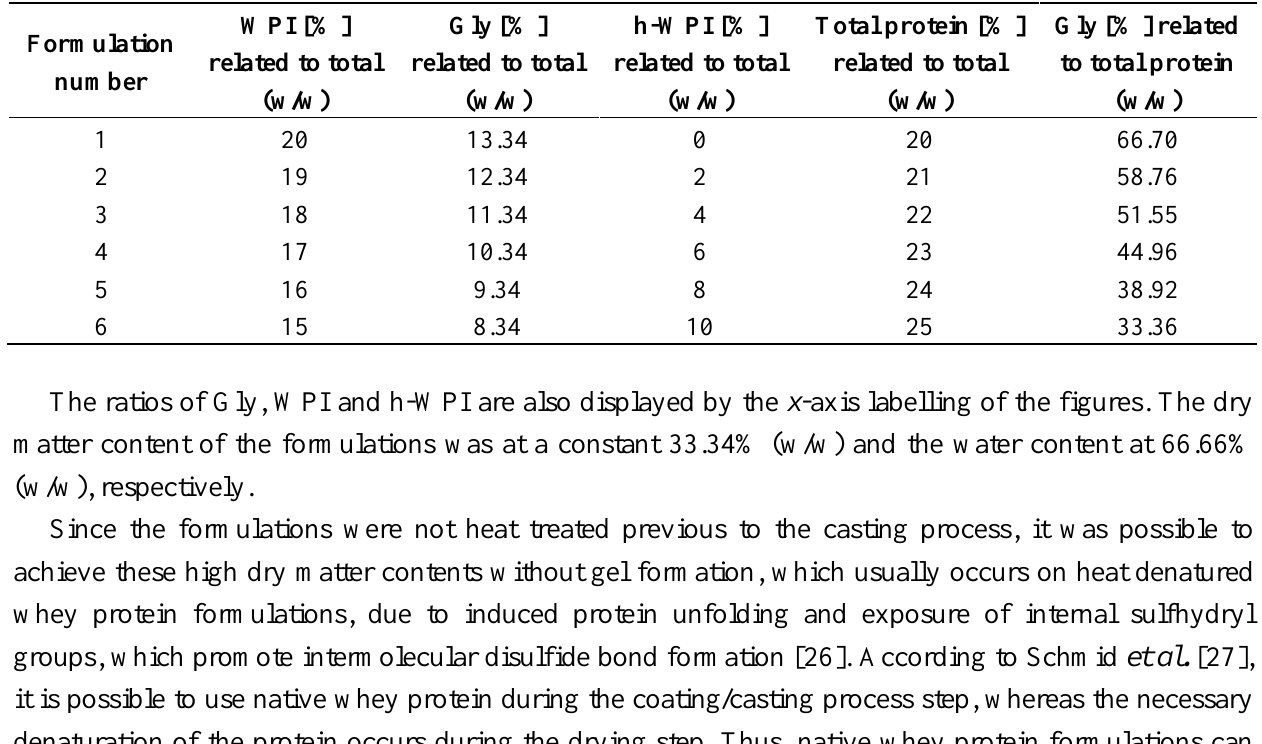
Table 1. Ratios of whey protein isolate (WPI), hydrolysed whey protein isolate (h-WPI) and glycerol (Gly) in aqueous